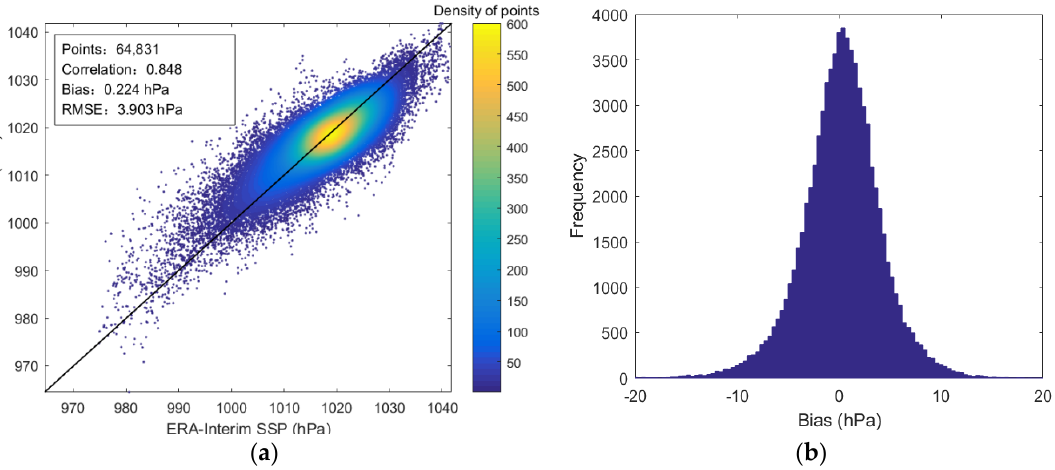
Figure 8. The retrieval result of SSP and the distribution of retrieval bias from MWHTS: ( a ) the retrieval result; ( b ) the distribution of bias.